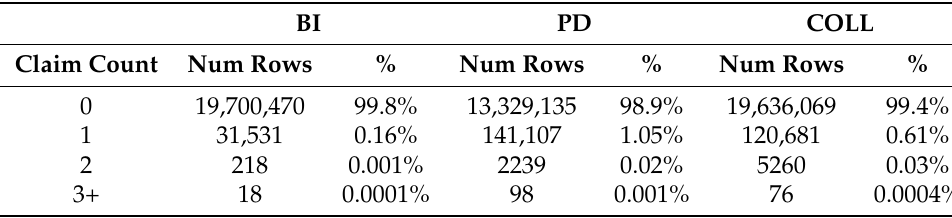
Table 4. Counts of the rounded values of ULTIMATE_CLAIM_COUNT.